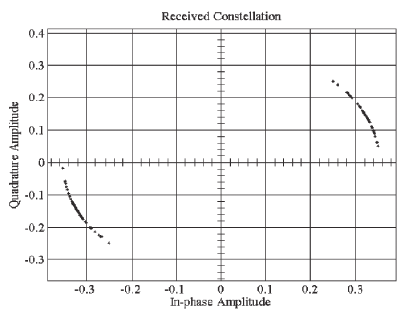
Fig. 8. Signal constellation for BPSK modulation scheme for a high level of phase noise (–48 dBc/Hz, frequency offset at 100 Hz): with convolutional coding (rate ¾, constraint length K = 7); satellite and ground receivers noise temperatures at 0 K; free space path loss 157 dB; HPAs backoff level 7 dB; phase offset is equal to zero; d 1 = d 2 = d 3 = d 4 = 1.0